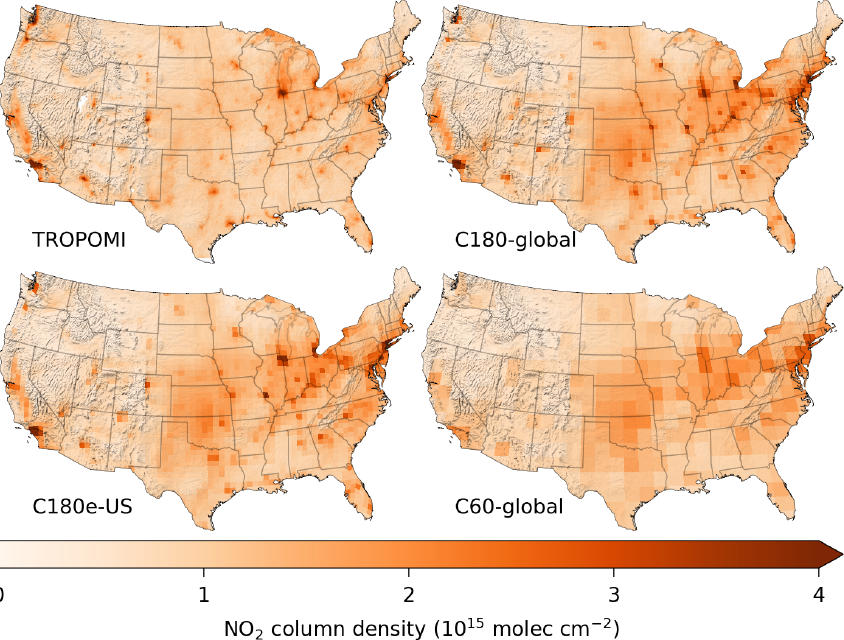
Figure 7. Mean tropospheric NO 2 column densities from C180-global, C180e-US, C60-global, and TROPOMI observations for July 2019. Simulated means only include points where TROPOMI observations were available. TROPOMI columns shown here use shape factors from C180e-US. TROPOMI columns with shape factors from C180-global were nearly identical. An annotated map of the contiguous US is provided in Fig. C1.